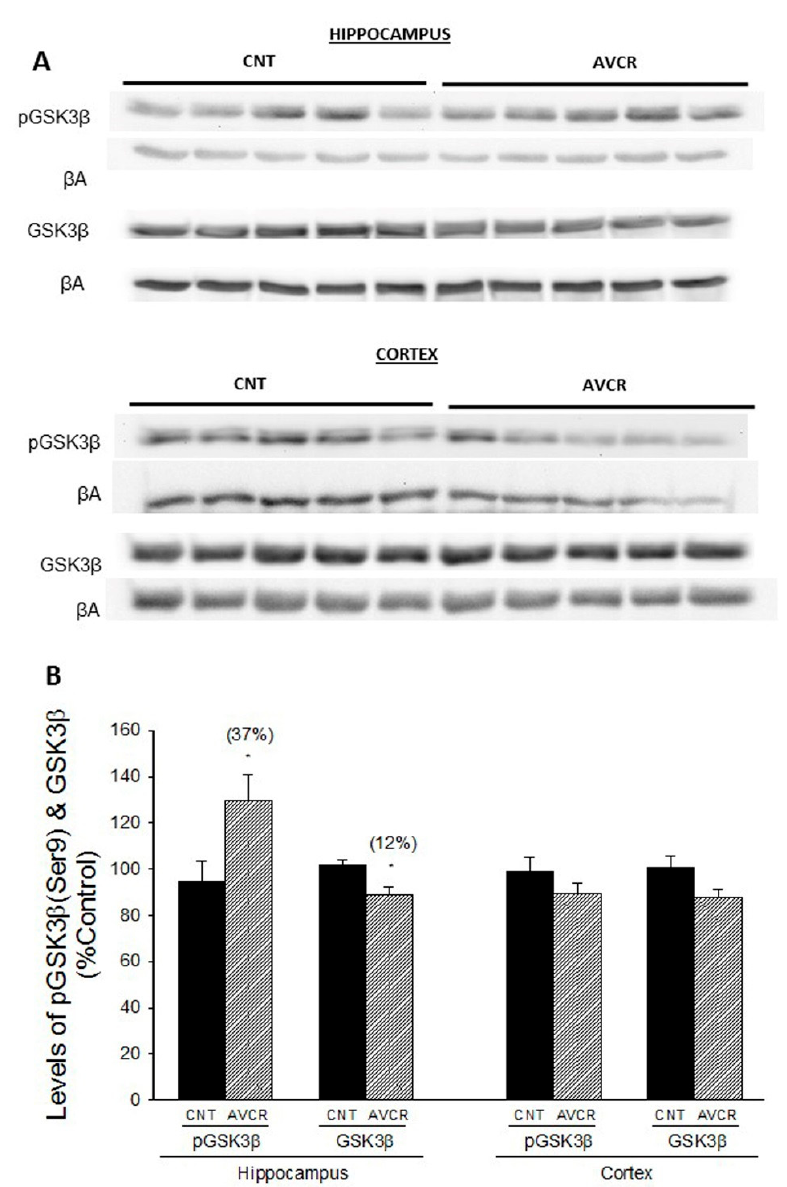
Figure 3. Effect of AVCRI104P3 on pGSK3 β (Ser9) and GSK3 β in the hippocampus and cortex of 12-month-old 129/Sv × C57BL/6 male mice. ( A ) Representative Western blot images of pGSK3 β (Ser9) and GSK3 β . β -actin were used as internal control. ( B ) Photodensitometric quantification of WB